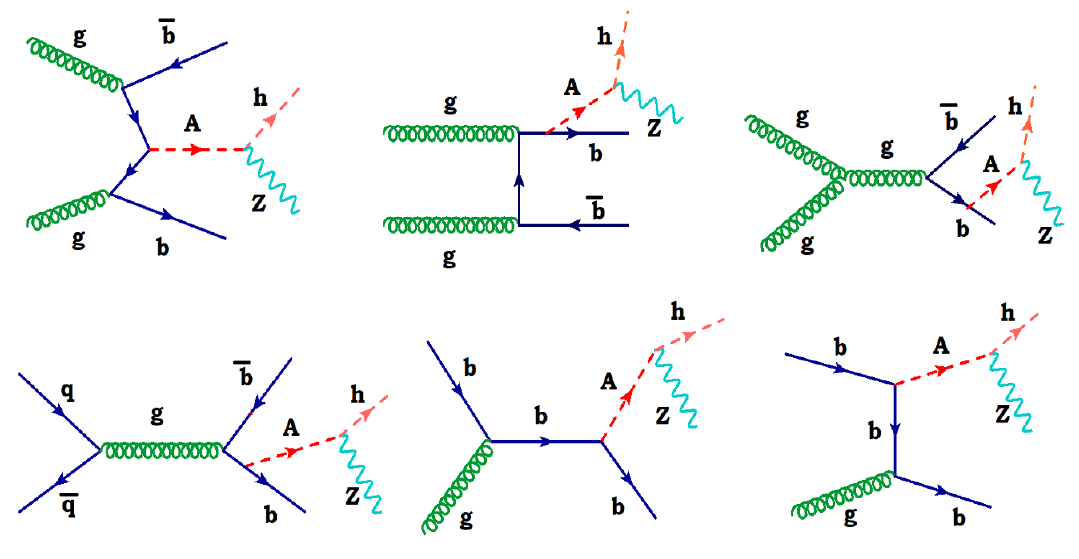
Figure 10 . Representative leading order Feynman diagrams for pseudoscalar A production in asso- ciation with b quarks and simulataneous decay to Z and h boson. The diagrams that can be obtained { 29